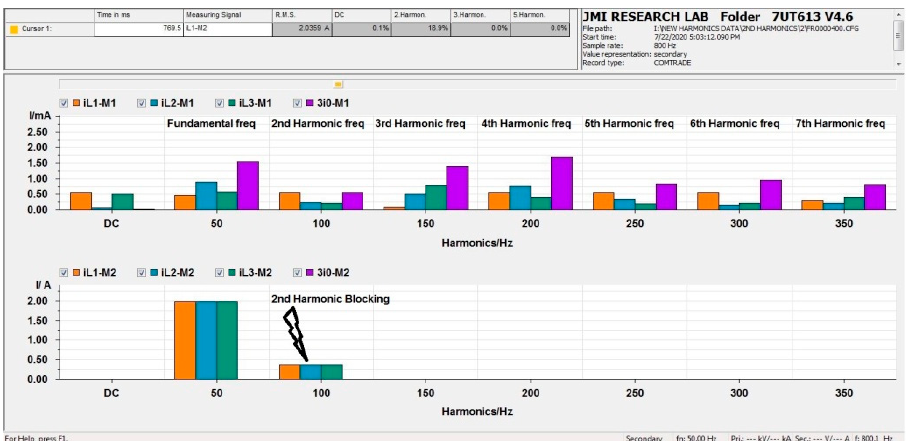
Figure 12. 2nd HB at 2000 mA Rated current & 18% of Inrush current condition.